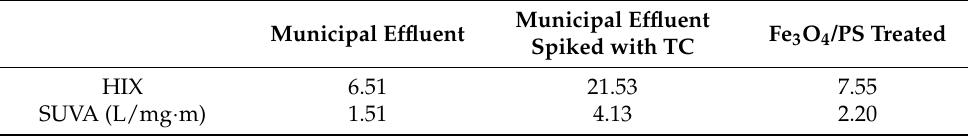
Table 3. Humidification index and SUVA 254 for the various water samples.